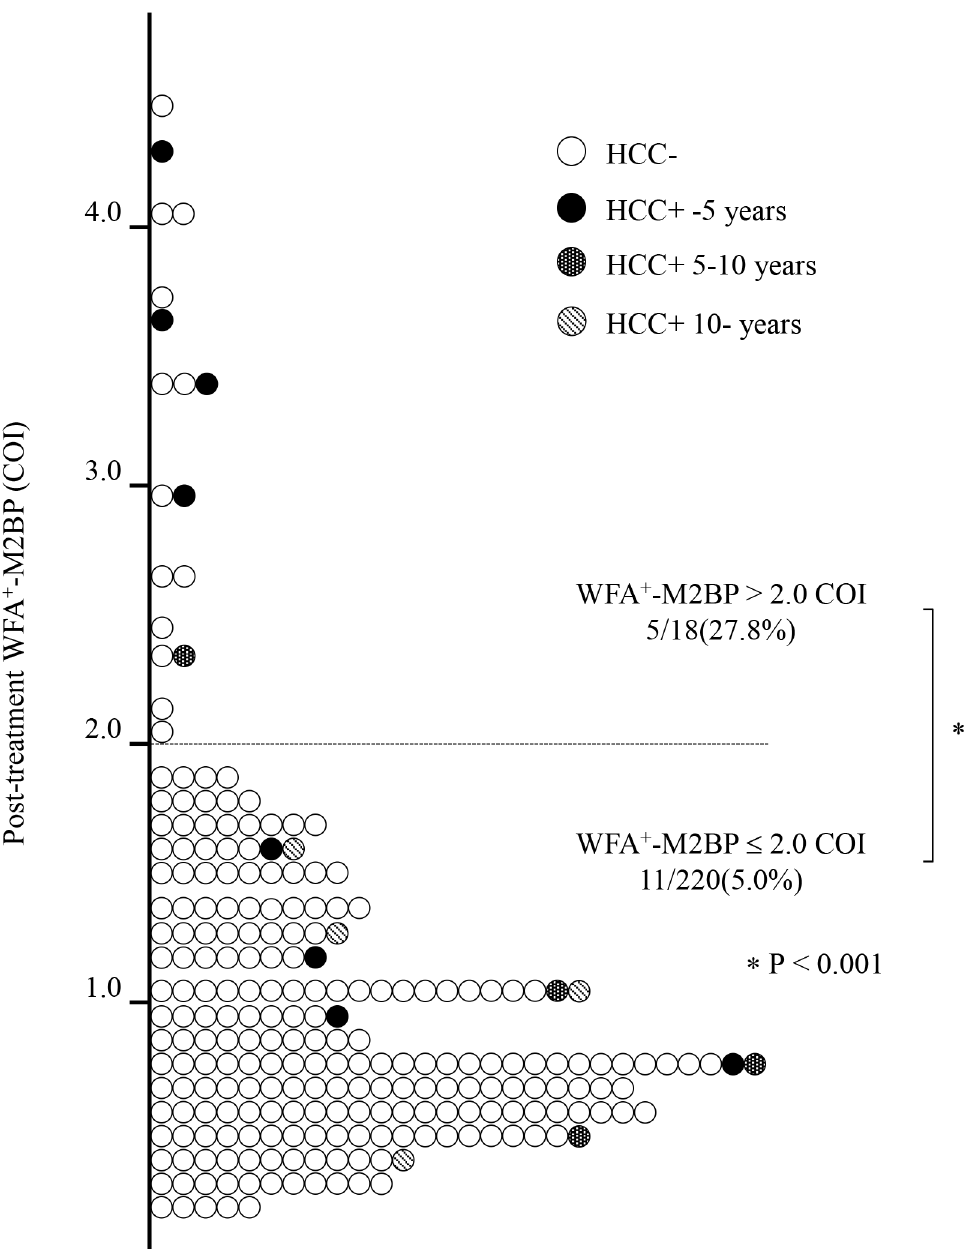
Fig 5. Relationship between post-treatment WFA + -M2BP values and HCC development. The distribution of WFA + -M2BP values was plotted. The dashed line indicates the 2.0 COI for WFA + -M2BP. The 16 patients who developed HCC were stratified according to the duration from SVR to HCC development in 5-year increments. Each time point is designated by a distinct symbol as indicated. 222 patients did not develop HCC, and 209 of these 222 patients (94.1%) were in the post-treatment WFA + -M2BP (cid:5) 2.0 COI group (white circles). During the follow-up period, 5 of 18 patients (27.8%) developed HCC in the post-treatment WFA + -M2BP > 2.0 COI group, which was significantly higher than the rate in the post-treatment WFA + -M2BP (cid:5) 2.0 COI group (5.0%, P < 0.001). In the post-treatment WFA + -M2BP > 2.0 COI group, 4 of 5 cases developed HCC within 5 years after IFN treatment (black